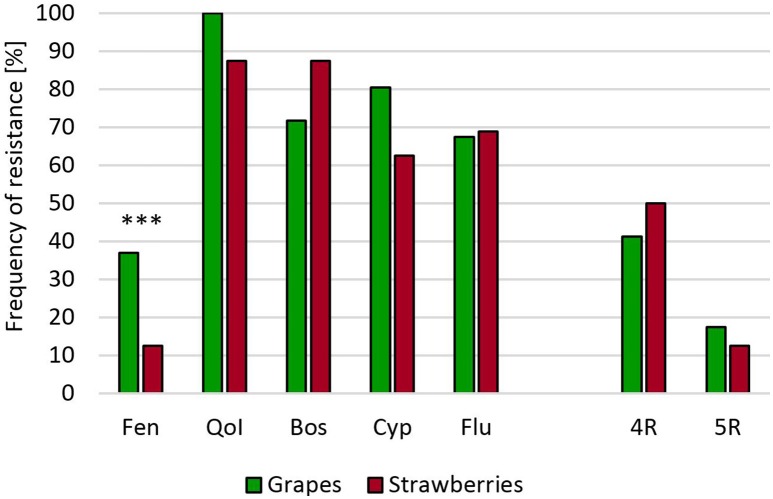
Resistance frequencies of B. cinerea isolates from a vineyard and a neighboring strawberry field in Southern Germany (2014). Abbreviations are as in Figure 2. ***p < 0.001.